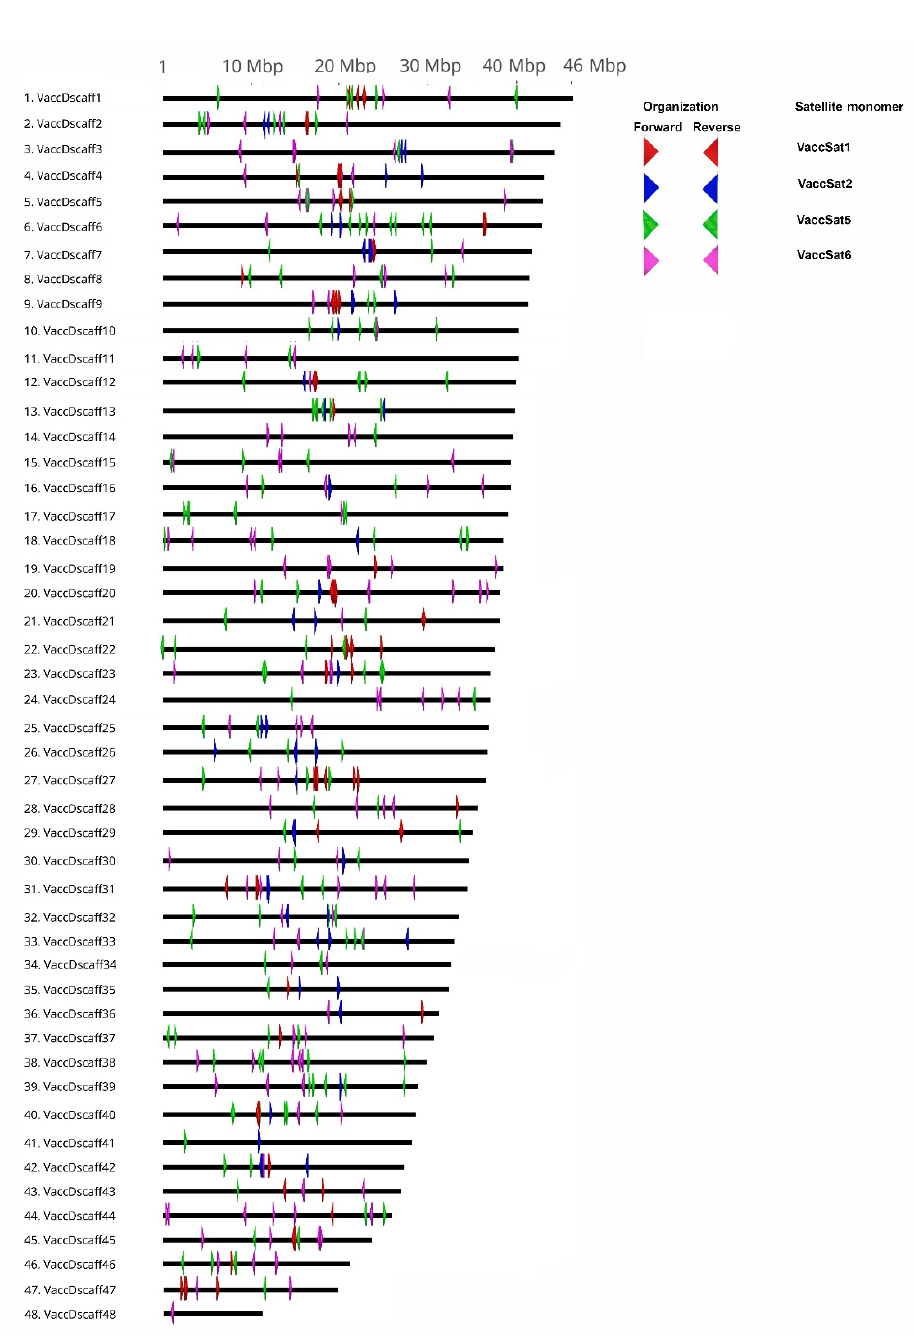
Figure 5. Distribution of the tandemly organized satellite families VaccSat1, VaccSat2, VaccSat5, and VaccSat6 along the 48 V. corymbosum pseudochromosomes. The individual VaccSat families are distinguished by arrowhead color, with red = VaccSat1, blue = VaccSat2, green = VaccSat5, and purple = VaccSat6. Forward and reverse oriented arrows indicate the orientation of monomers and arrays.